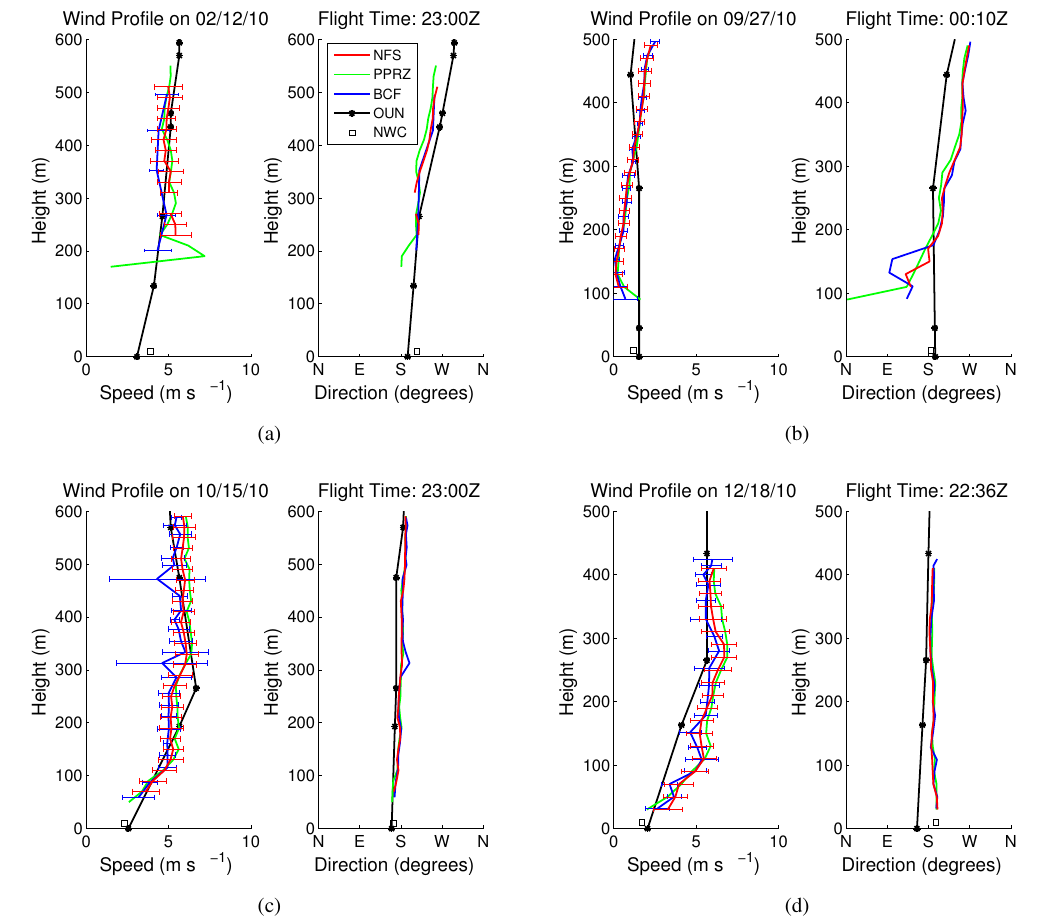
Fig. 5. Four examples of typical wind profiles using the different algorithms compared against the NWC Mesonet observation at 10m (NWC, black square) and the rawinsonde (OUN, solid black line with asterisks). NFS is the no-flow-sensor (red line), PPRZ is the paparazzi output (green line), BCF is the best curve fitting method (blue line).